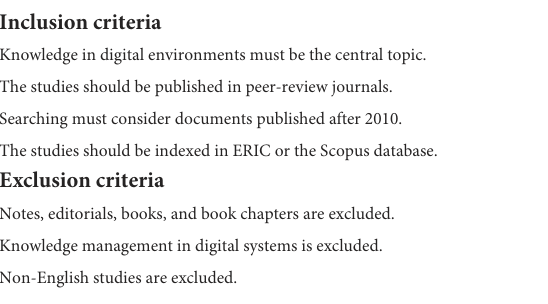
TABLE 1 Inclusion and exclusion criteria for knowledge in digital